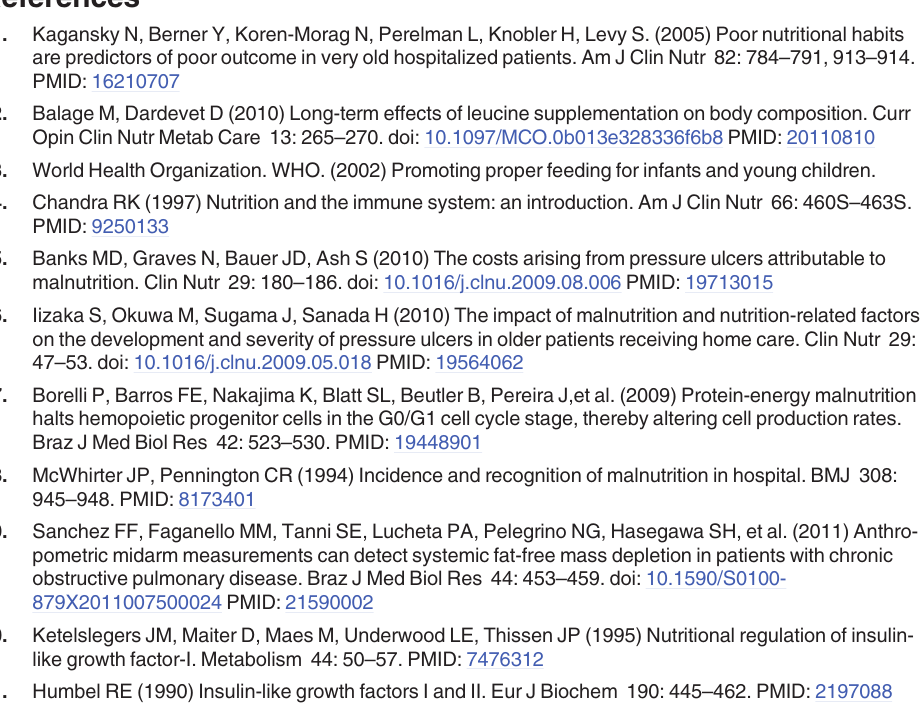
S1 Fig. Study Design. Our study included 5 treatment groups, including 2 control groups (a normal control group that was fed chow and ad libitum water [CON] and a malnourished con- trol group [MC] that was fed a 50% chow diet). After undergoing the weight loss stage, rats re- ceived either the chow diet (MC-CON), the chow diet supplemented with low-dose leucine (MC-L), or the chow diet supplemented with high-dose leucine (MC-H). S1 Table. Primers Used for Reverse Transcriptase Quantitative PCR